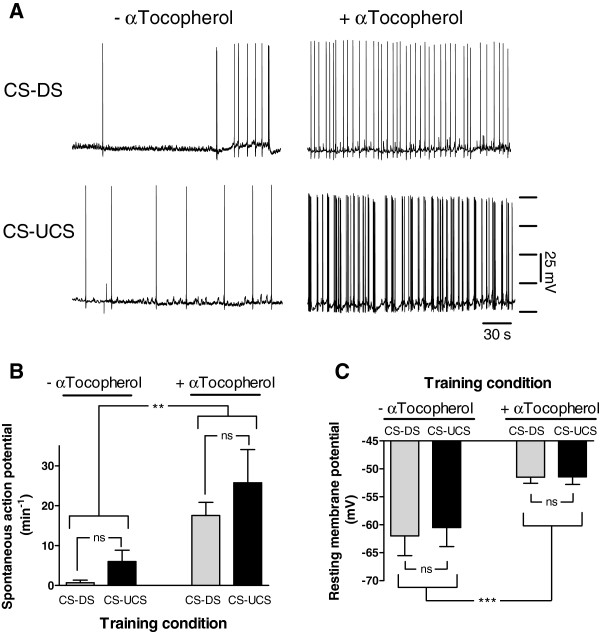
Effect of α-tocopherol treatment on electrical activity CGCs. A. Examples of intracellular recording of spontaneous electrical activity in CGCs of control (CS-DS) and conditioned (CS-UCS) senior animals with supplementation of vehicle only (− αTocopherol) or with α-tocopherol (+ αTocopherol). B. Average number of spontaneous action potentials of CGCs in vehicle only and α-tocopherol treated conditioned and control animals. α-tocopherol caused an significant increase in the number of spontaneous action potentials recorded from CGCs compared with CGCs taken from vehicle treated animals. No significant effect was observed of conditioning on spontaneous electrical activity in both dietary treatments. C. CGC resting membrane potential of α-tocopherol treated snails was significantly more depolarized compared with vehicle only treated animals. Behavioural conditioning had no effect on resting membrane potential in both treatments. * = p < 0.05, ** = p < 0.01, *** = p < 0.001, ns = non-significant.